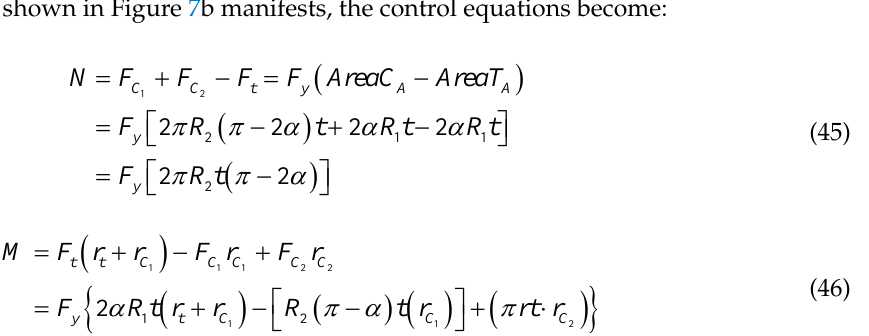
Figure 7. Loading conditions of undeformed and ovalised shell cross sections, ( a ) tubular shell cross section without ovalisation and ( b ) ovalised tubular shell cross section.